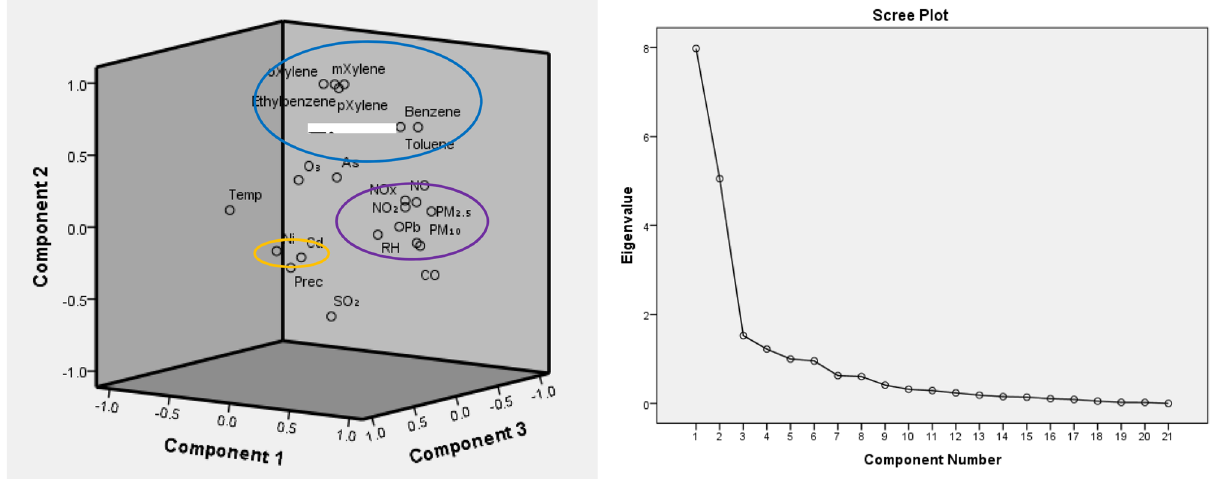
Figure 6. Component plot in rotated space (left), and scree plot (right) of the studied air